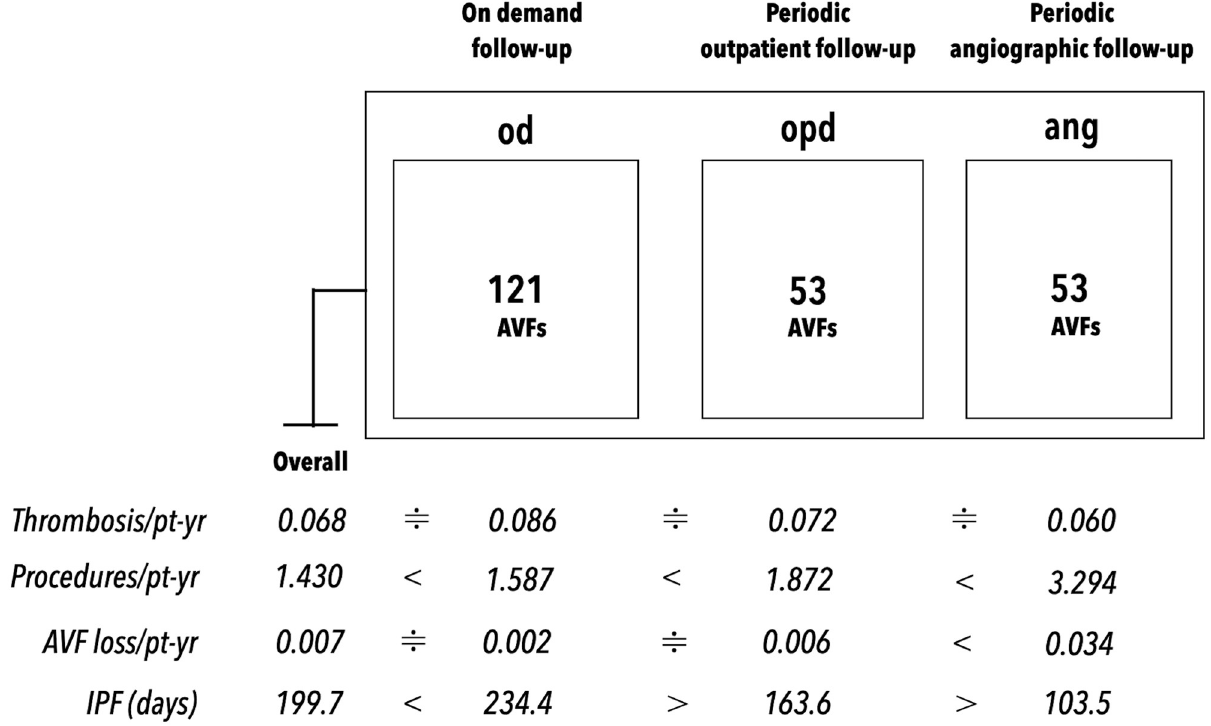
Fig 4. Follow-up outcome measures of the protocol and sub-protocols. Mathematical symbols: A > B or A < B imply that the value of A is statistically different from B; A ≑ B implies that the values of A and B were not statistically different. The thrombosis rate among the three sub-protocols was not statistically different, indicating the performances of the three sub-protocols for prevention of AVF thrombosis were equivalent.